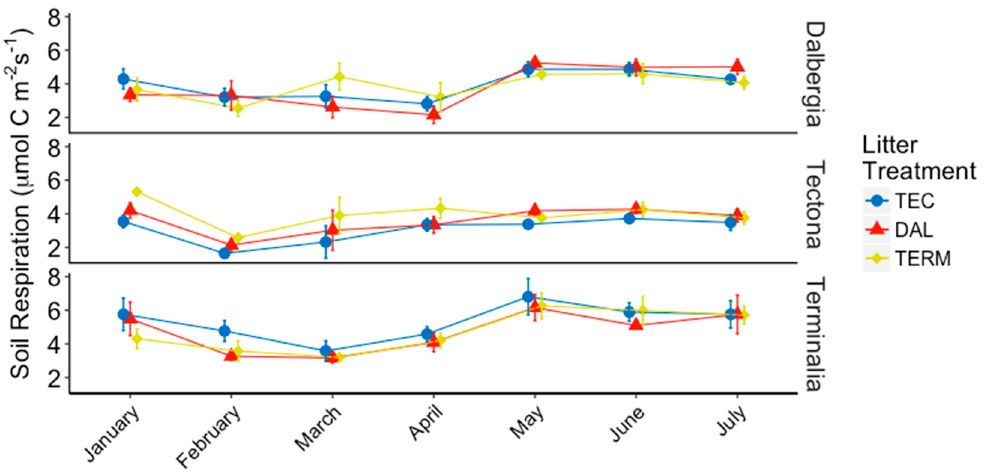
Figure 3. Soil respiration in a litter decomposition experiment in monoculture plantations of Tectona grandis , Dalbergia retusa and Terminalia amazonia in Panama, Central America, where TEC (blue circles) is Tectona grandis litter , DAL (red triangles) is Dalbergia retusa litter and TERM (yellow diamonds) is Terminalia amazonia litter. The measurements were taken over the mesocosm ( n = 5 per plantation) every month during 7 months from May until July 2017.